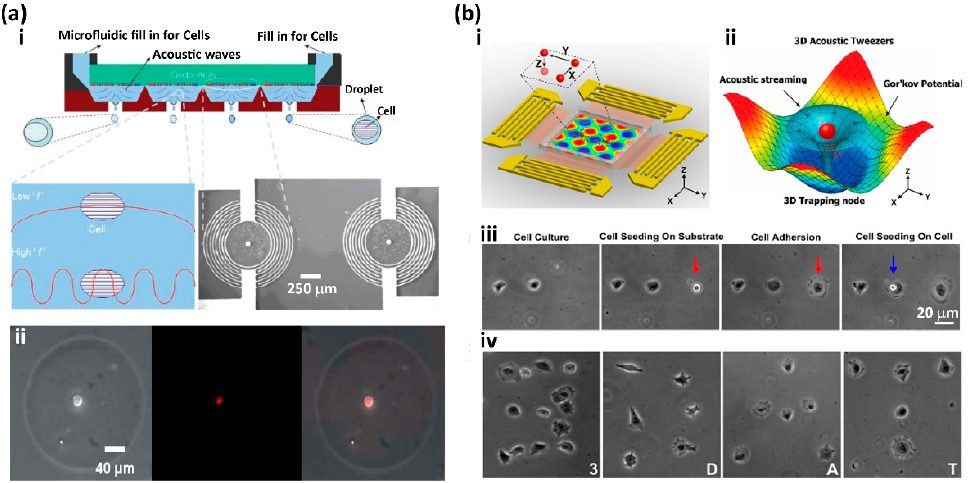
Figure 2. Acoustic field-assisted single-cell printing: ( a - i ) The setup of the acoustic picolitre droplet generator. ( a - ii ) A single 3T3 fibroblast cell with cell tracker dye was printed on a glass substrate (from left to right: white field image, fluorescent image, and the overlap image). Reproduced with permission from [45]. ( b - i ) Schematic illustration of the planar surface acoustic wave generators. ( b - ii ) Numerical simulation results of the surface acoustic wave-based 3D acoustic tweezer. ( b - iii ) The single 3T3 mouse fibroblast can be precisely printed to the desired position, either on the substrate to form a linear cell array (red arrow) or on the top of another cell (blue arrow). ( b - iv ) HeLa S3 cells were printed on a substrate to form the pattern of letters: “3” “D” “A” “T”. Reproduced with permission from